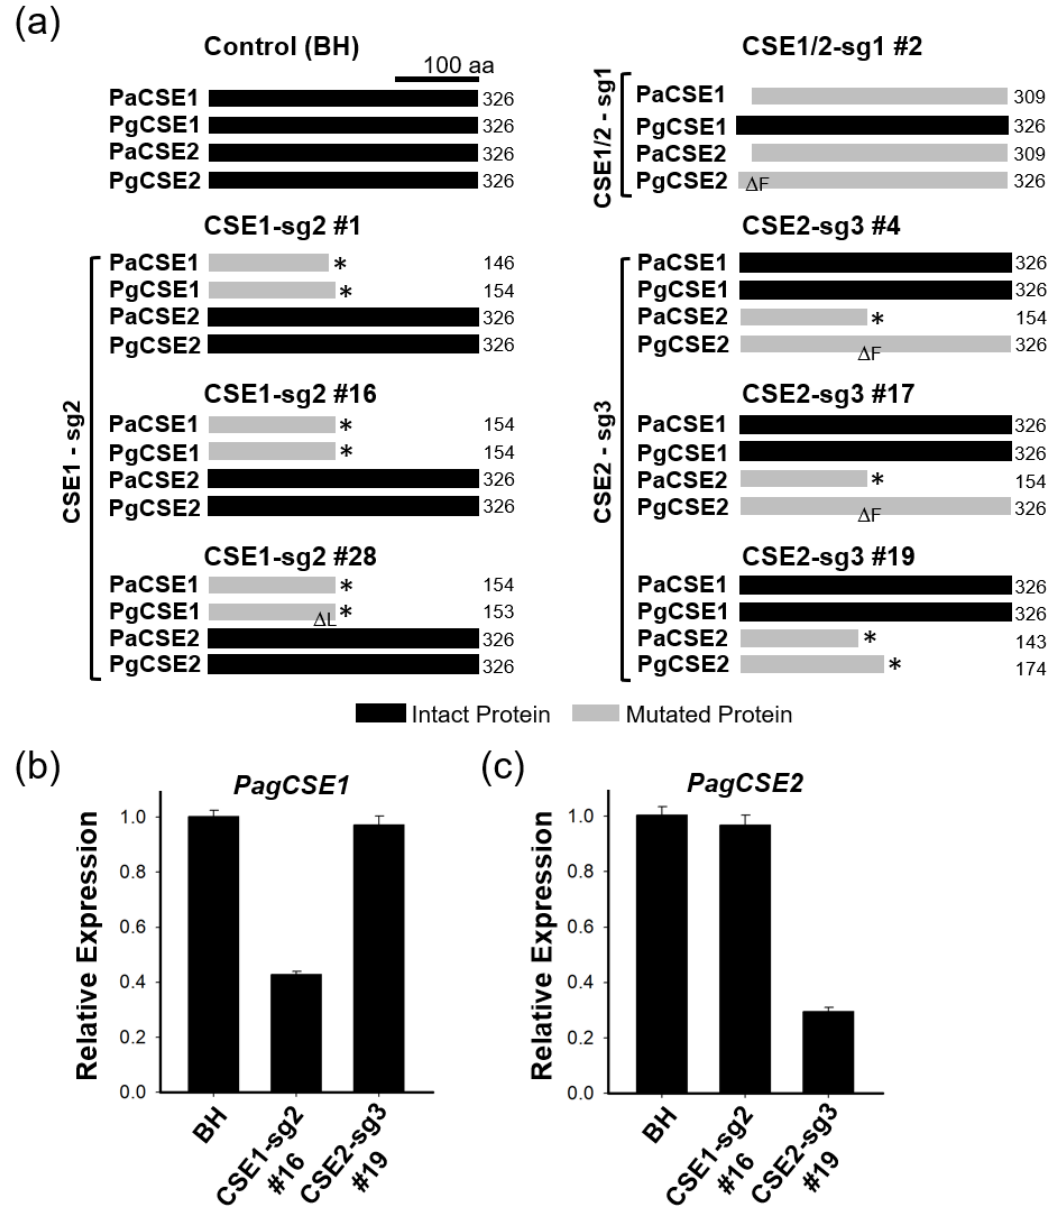
Figure 2. Predicted CSE protein and CSE gene expression in transgenic CSE-CRISPR hybrid poplars. ( a ) Summary of mutations in each transgenic CSE-CRISPR poplar line. Expected normal CSE proteins in the control (BH) are shown as black bars with corresponding sizes. CSE proteins mutated by CRISPR editing are shown as gray bars with corresponding sizes. Asterisks indicate non-sense mutations, and means a deletion of an amino acid. ( b , c ) Expression of CSE gene in CSE-CRISPR poplars. Quantitative real-time PCR (RT-qPCR) was performed using primers targeting the c-terminal regions shown in (Figure 1a) ( n = 6, error bar = S.E.). PagCSE1 indicates both PaCSE1 and PgCSE1 .